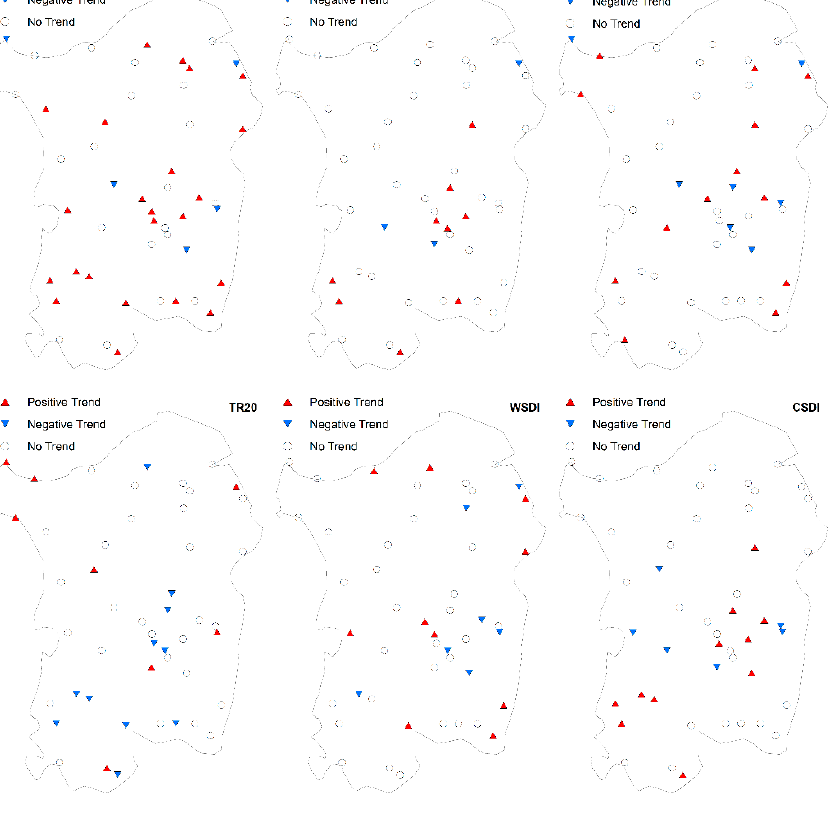
Figure 9. Spatial distribution of extreme temperature indices trend (DTR, FD, SU25, TR20, WSDI and CSDI; see Table 3 for abbreviation definitions).